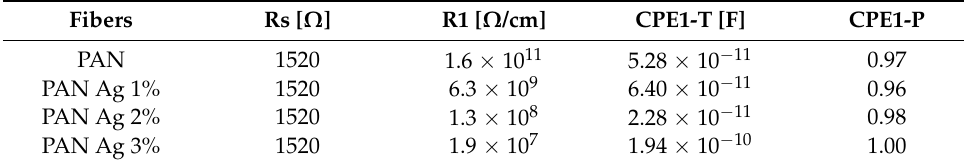
Table 2. Values of particular elements of the equivalent circuit model.